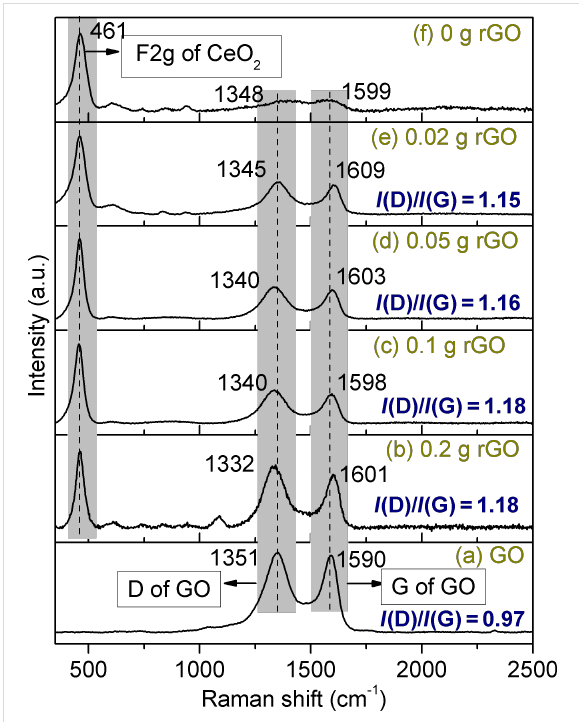
Figure 1: Raman spectra of GO (a); of CeO 2 with rGO-like organic residues (sample rGO(0)–CeO 2 ) (f); and of rGO–CeO 2 composites with different proportions of added rGO (b–e) after solvothermal treat- ment in ethanol.